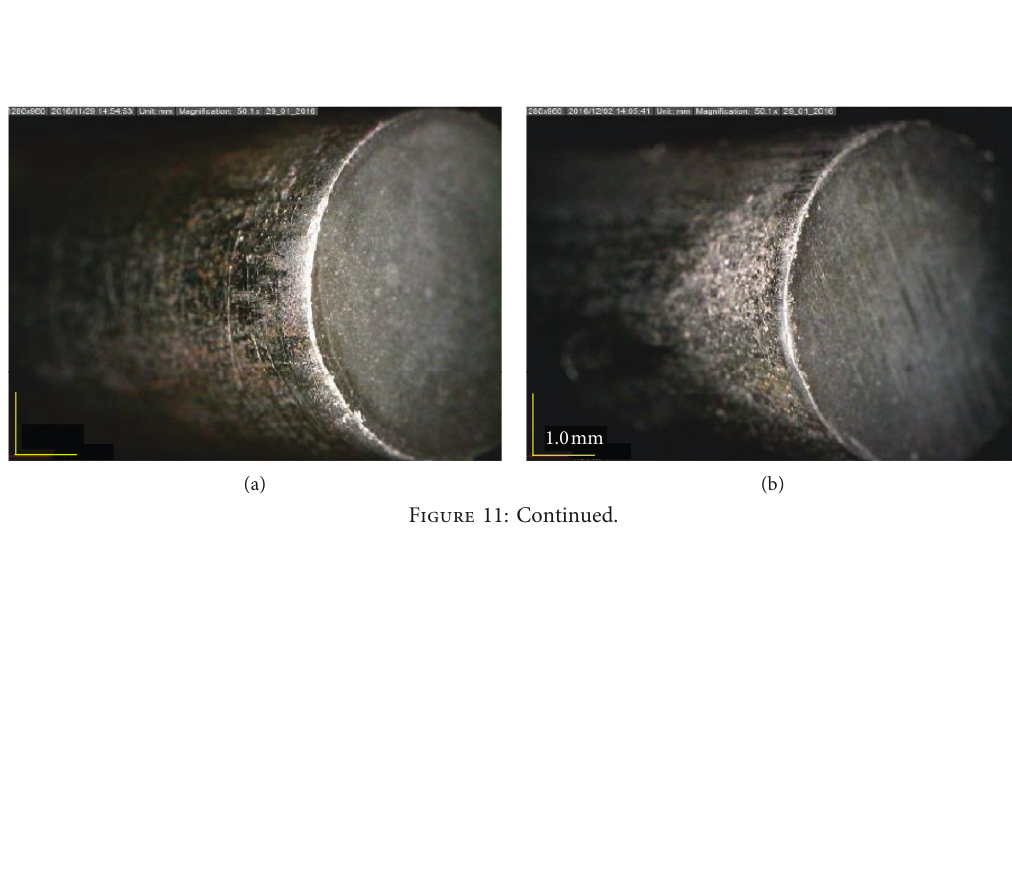
Figure 10: Edge and face wear of the flat edge of slot punch at the 26.500 strokes (slot punch 10.5 × 8.5 × 100mm in size). (a) HT (OM × 50). (b) CT (OM × 50). (c) HT(SEM × 100). (d) CT (SEM ×